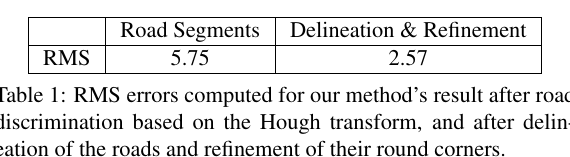
Figure 6: A closer look at some roads’ delineations resulted by our proposed method (the blue lines); comparing to the ground truth (the green lines), and the segment boundaries computed by Hough transform (the red lines).